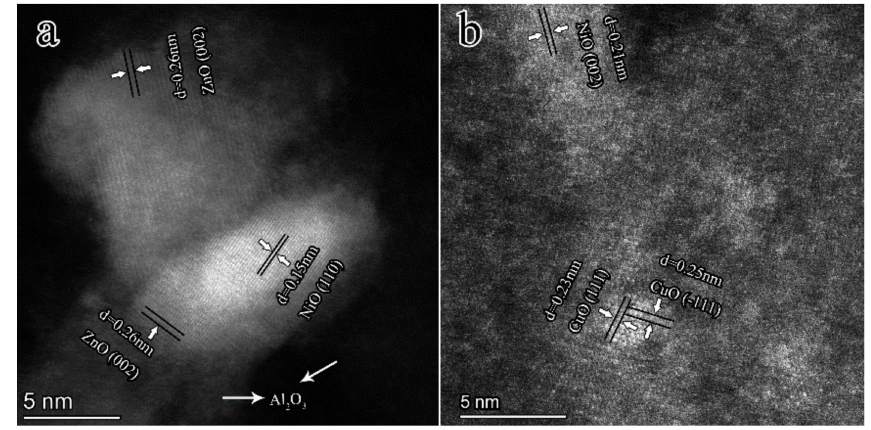
Figure 3. HRTEM images of ( a ) 10Ni4Zn / Al 2 O 3 and ( b ) 10Ni4Cu / Al 2 O 3 after calcination.